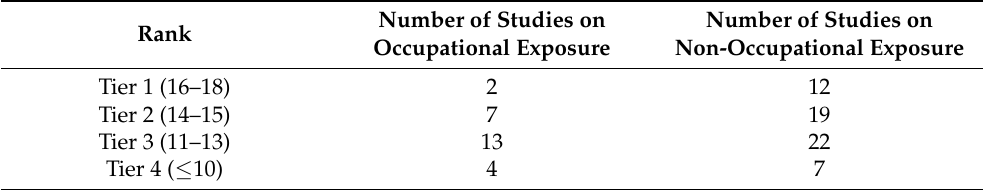
Table 3. Summary of the quality assessment of the studies included in the review. Number of Studies on Number of Studies on Rank Occupational Exposure Non-Occupational Exposure Tier 1 (16–18)